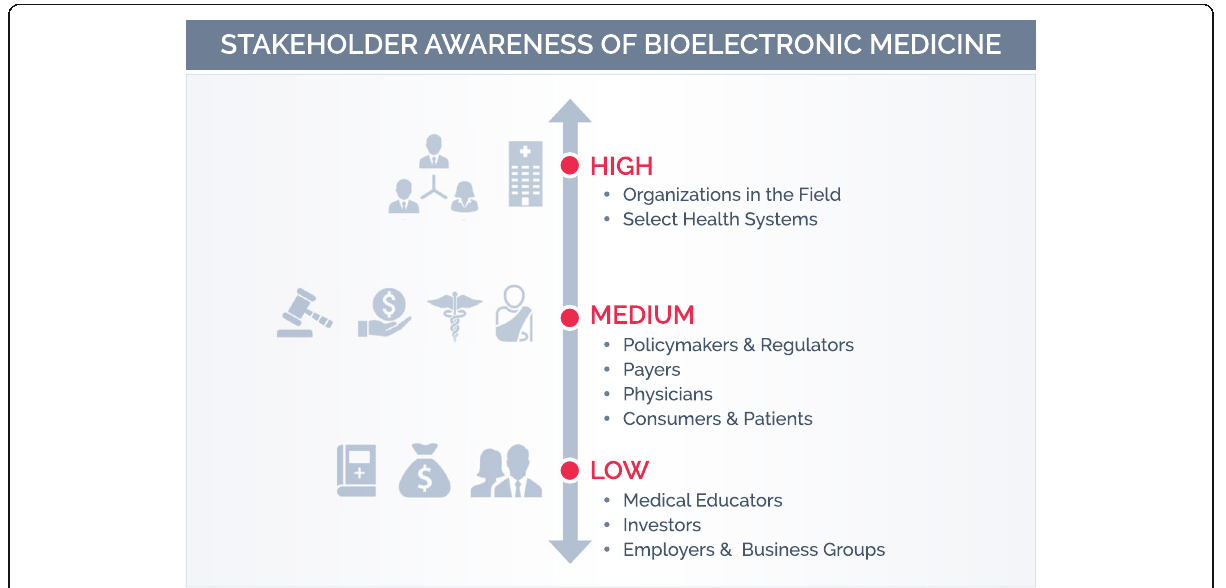
Fig. 2 Stakeholder Awareness of Bioelectronic